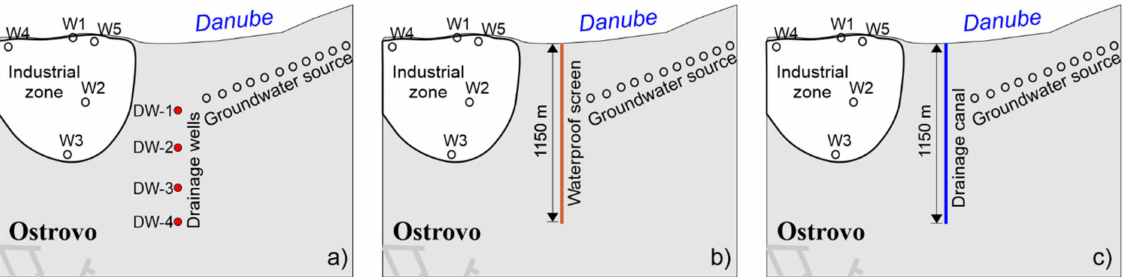
Figure 15. Schematic representation of the alternative plans. ( a ) Plan 1—Drainage wells; ( b ) Plan 2—Waterproof screen; ( c ) Plan 3—Drainage